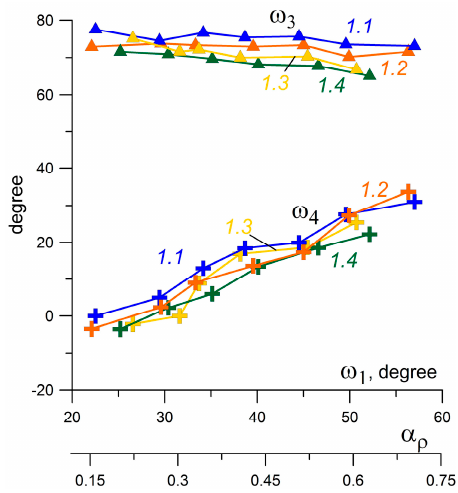
ω ω ω α ρ for different γ 3 and 4 on 1 and